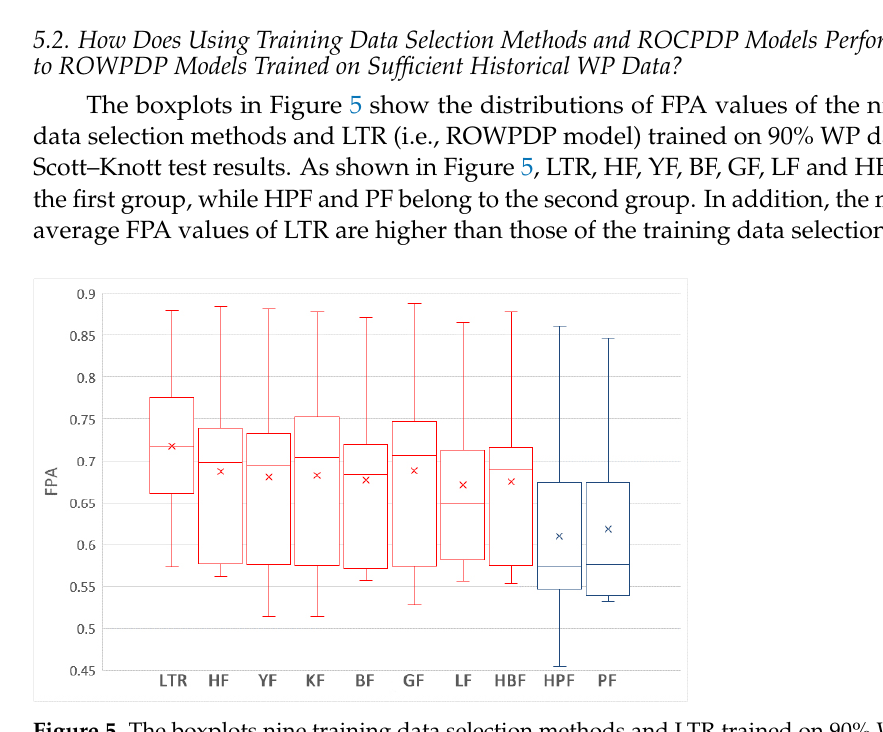
Figure 5. The boxplots nine training data selection methods and LTR trained on 90% WP data with the Scott–Knott test results in terms of